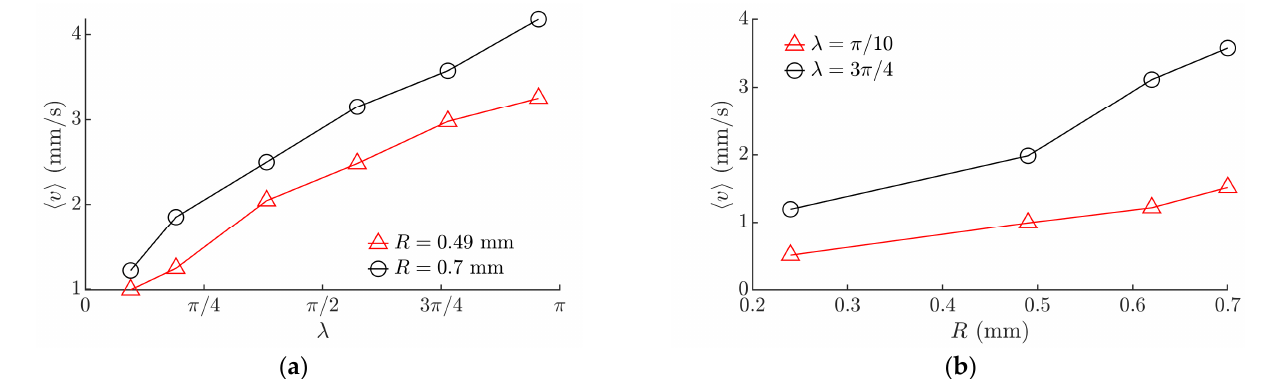
Figure 12. Experimental results of the average velocity depending on the following: ( a ) λ when ω = 62.83 rad/s, ϕ = 0; ( b ) the radius of the circular motion of the platform R when ω = 62.83 rad/s, ϕ = 0.